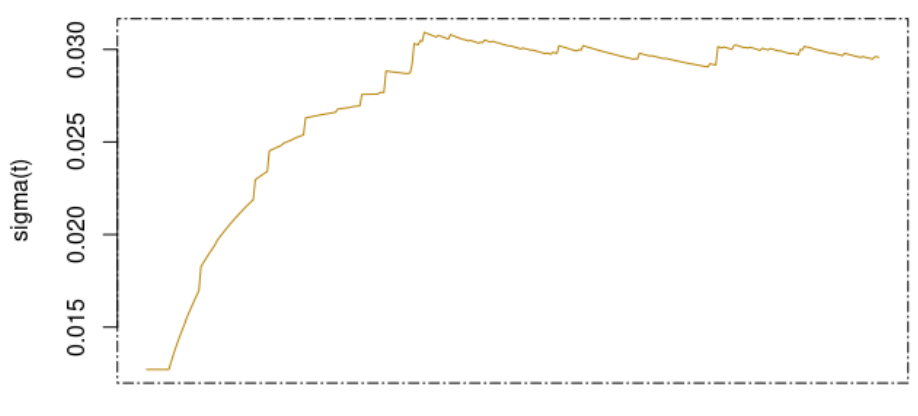
Figure 12. Volatility extracted from AR(1)-GJR-GARCH(1,1) model for Gold bullion price per ounce (GOLD)—Reuters’ Datastream.